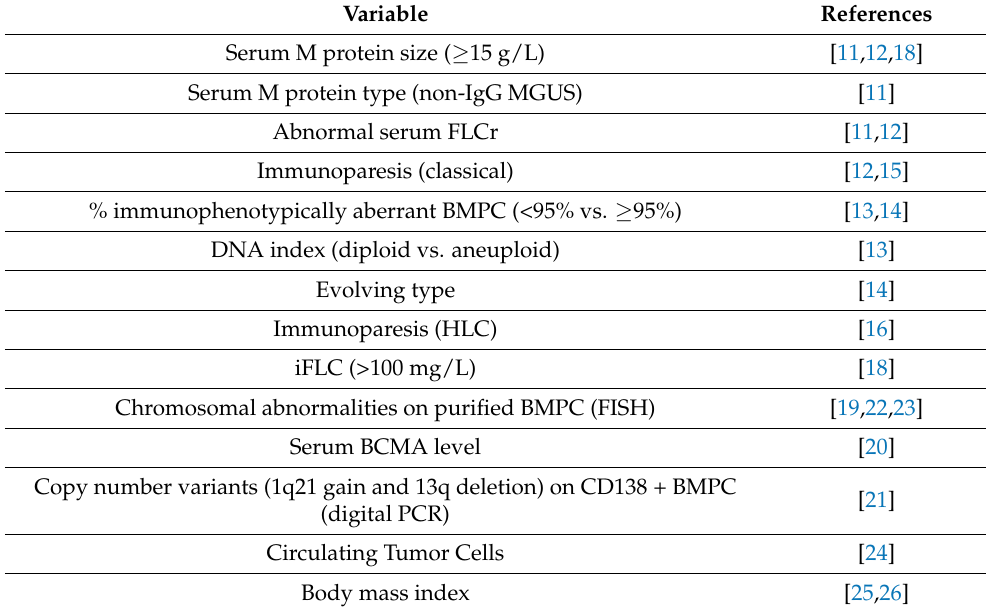
Table 3. Variables influencing the risk of progression in individuals with